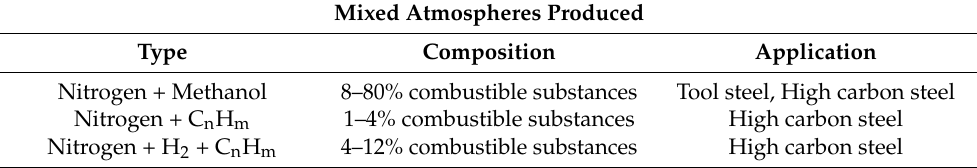
Table 3. Mixed atmospheres used during